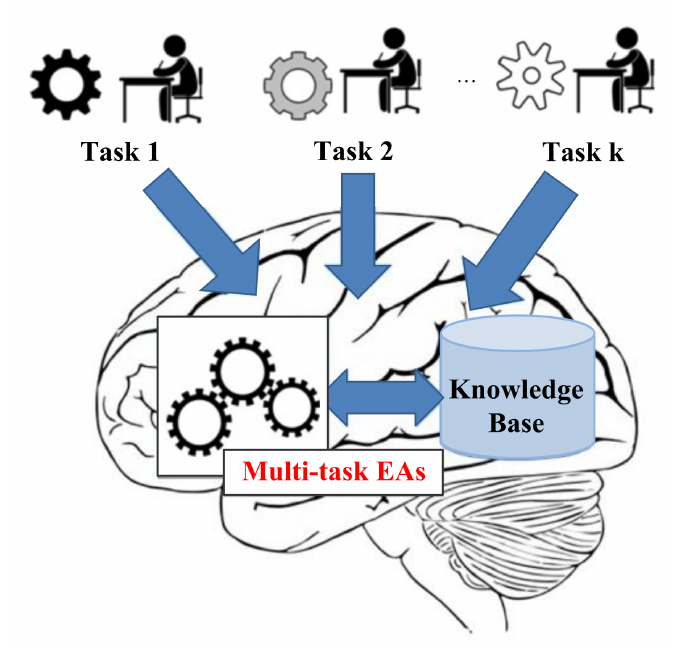
Figure 1. An illustration of a multi-task optimization problem